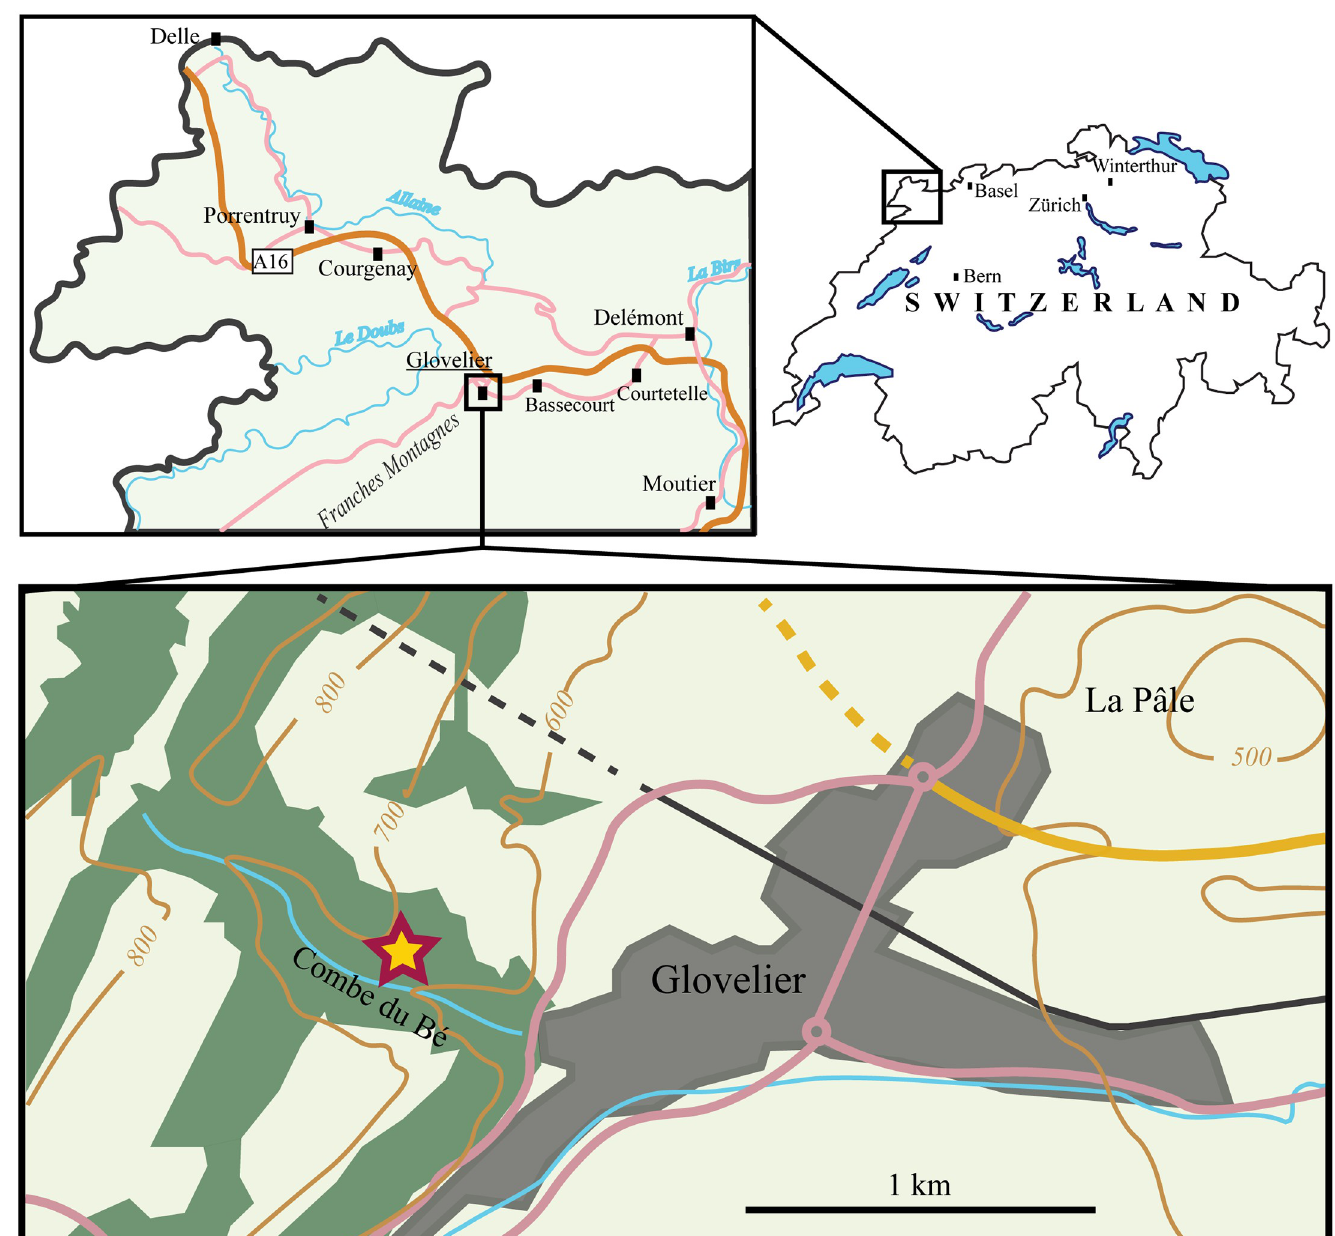
Fig 2. Stratigraphical column of the Reuchenette Formation in northwestern Switzerland. The shell marks the position of the new specimens in the Banne´ Marls (CBE: Combe du Be´, name of the locality). Modified from Pu¨ntener et al. [11].